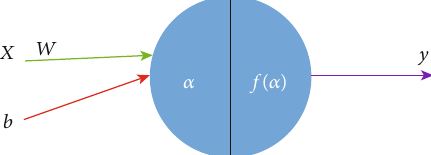
Figure 4: Architecture of the DNN